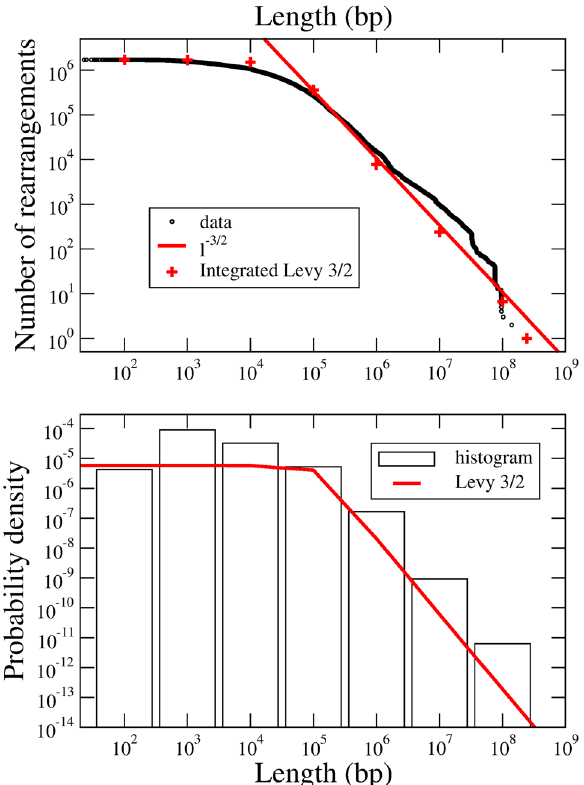
Figure 4. Top: Log–log plot of the integrated size distribution of CNVs in germline cells. The red line is a fit 5 3 / 2 with the function 1 / l for l > 10 bp whereas the red crosses come from the integral Levy 3/2 distribution. Bottom: A direct comparison of α L 3 / 2 (α l ) with a log-contracted histogram of the